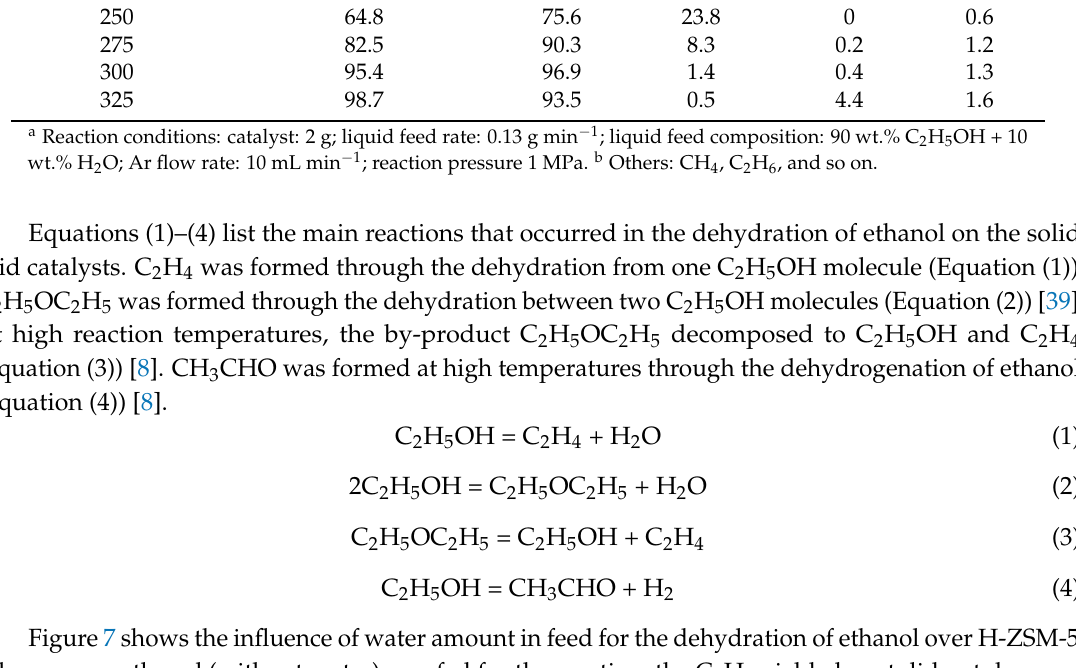
Table 2. Effect of reaction temperature in the dehydration of ethanol over H-ZSM-5 a . Temperature ( ◦ C) C 2 H 5 OH Conversion (%)